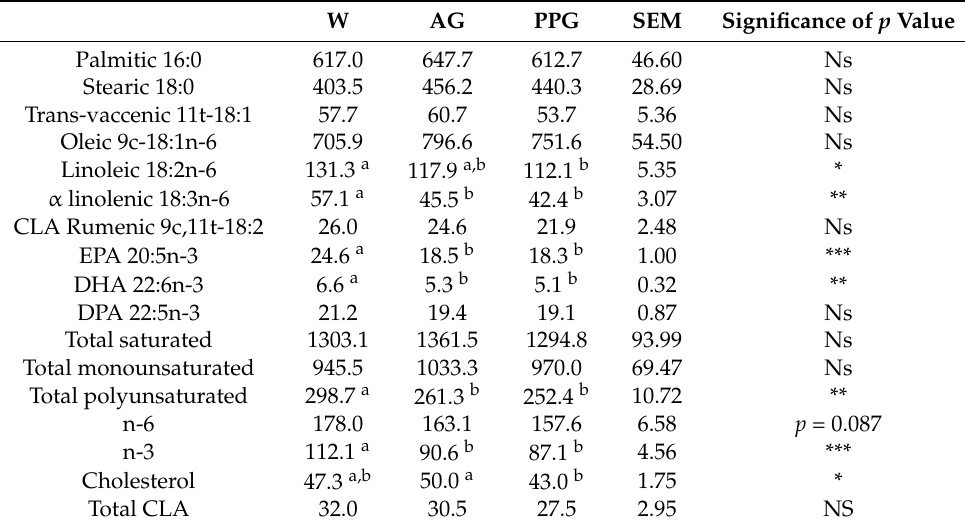
Table 8. Fatty acid content (mg 100 g − 1 ) of longissimus muscle in three production